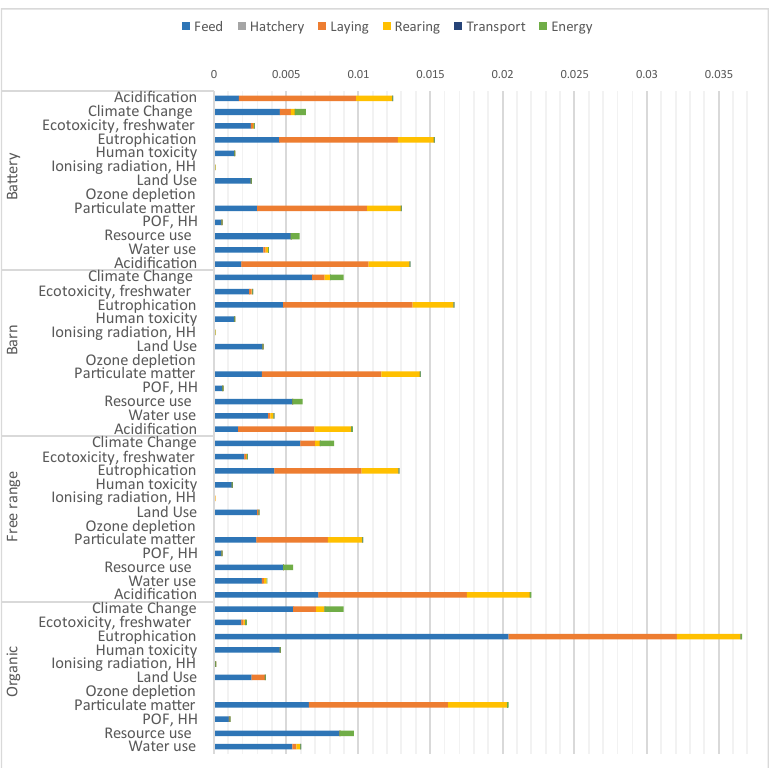
Figure 3. Normalized and weighted results for all impact categories for the different laying systems using Environmental Footprint 3.0 for one kilogram of